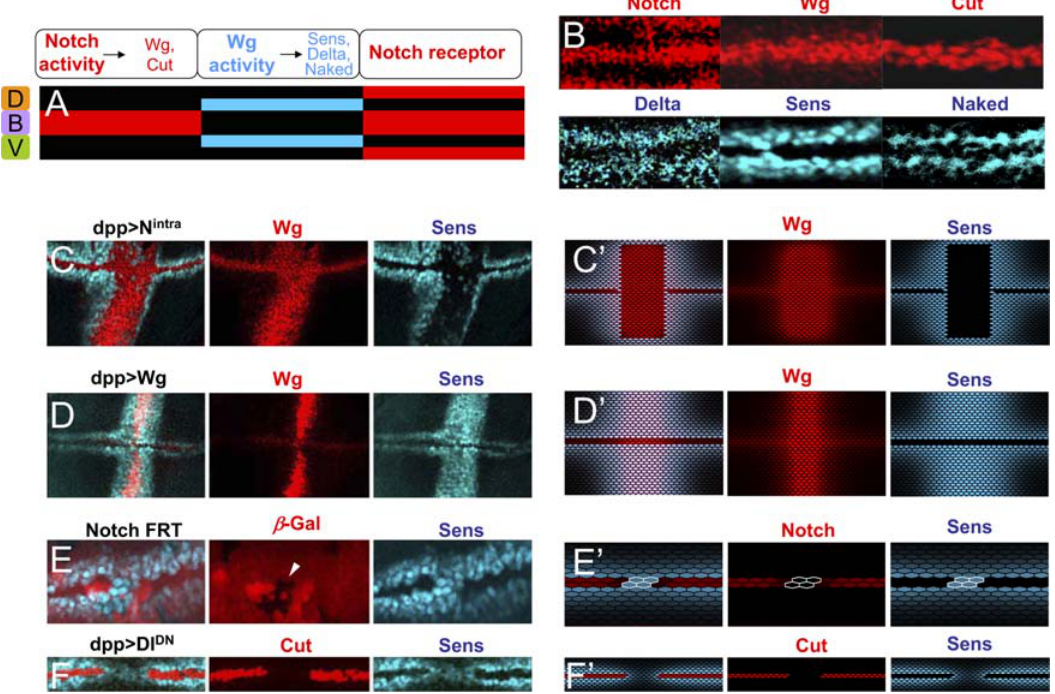
Figure 3. Refractoriness to Wg is defined by Notch. (A) Schematic representation of the results pointed out by (B) in regard of the expression pattern in DV boundary and neighboring cells. Several cell populations can be distinguished at and around the DV boundary in terms of the expression of Notch protein and the activity of Notch and Wg pathways. Orange, green, and violet squares highlight the D and V compartments, and the DV boundary, respectively. (B) High magnification of the DV boundary of mature wild-type wing discs showing, in red, Wg and Cut protein expression in boundary cells as well as higher levels of Notch protein expression in boundary and neighboring cells. Non-boundary cells show, in blue, high levels of Delta and Senseless (Sens) protein and naked mRNA. As revealed by Cut and Sens expression, the width of the boundary and flanking cell populations comprise a small number (two-three) of cells. (C,D) Mature wing discs expressing the intracellular domain of Notch, N intra , (C) or Wg (D) under dpp Gal4 control. In the first case, Gal4-expressing cells do not respond to Wg whereas in the second case they do. (E) Small clones of cells in the boundary lacking Notch activity marked by the absence of GFP (red) and pointed out by means of a white arrowhead. Sens protein (in blue) starts to be expressed in boundary mutant cells. (F) Mature wing disc that expresses a dominant negative form of Delta (Delta DN ) under dpp Gal4 control. Note that boundary cells lacking Cut expression (in red) start to express Sens (blue). (C’–F’) In silico counterparts of the results shown in (C–F). Ectopic expression of activation of Notch (C’) or Wg (D’). (E’–F’) As occurs in vivo , the absence of Notch activity in the boundary causes those cells to lose Cut expression and to start responding to Wg.